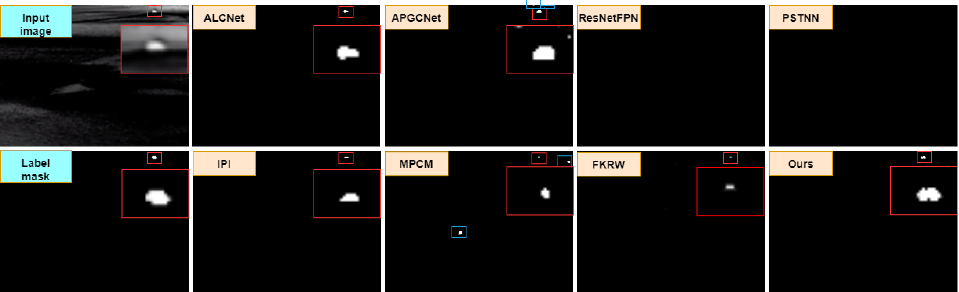
Figure 9. Detection results of infrared small targets in Scene 2 using different detection methods.